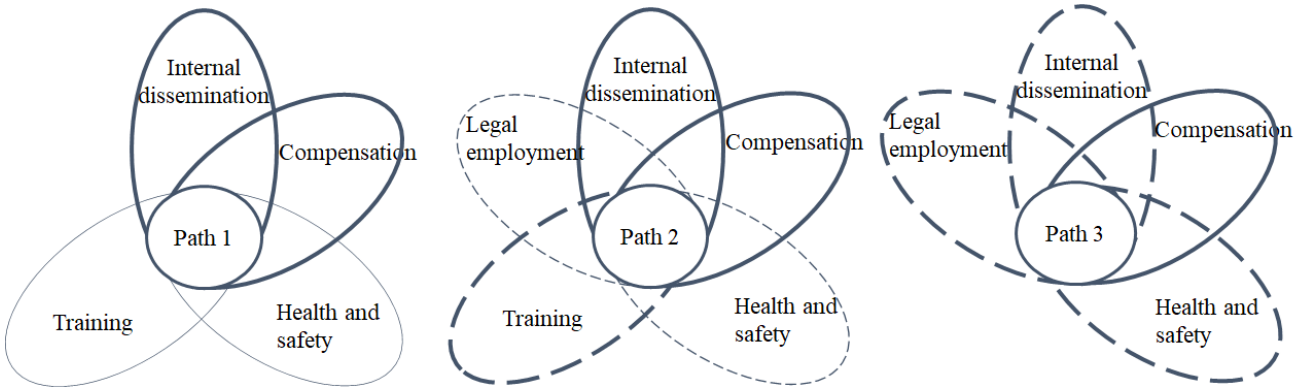
Figure 2. Causal configurations for high levels of positive spillover (Paths 1, 2) and negative spillover (Path 3). Note: The solid ellipse represents the presence of the condition, the dotted ellipse represents the absence of the condition, the bold ellipse for core conditions, and normal ellipse for peripheral conditions. If no ellipse is displayed, it belongs to the “Don’t care” condition.